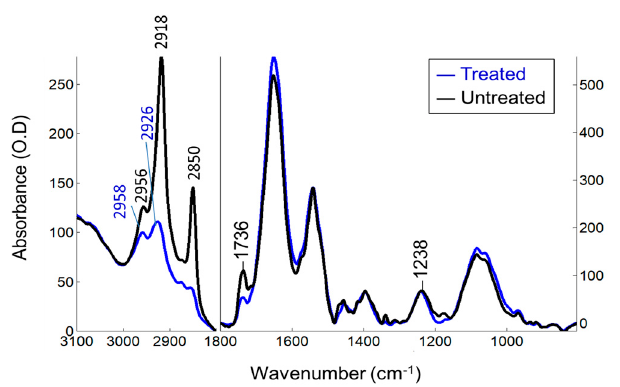
Figure 1. The FTIR mean absorbance spectra for CPT - treated and untreated Jurkat cells. The mean spectra were calculated by averaging at least 12 spectra recorded for repeated experiments of each cell condition. The spectra were baseline corrected and normalized to the same area underneath 1585– 1482 cm − 1 . Thus, the absorbance scale presents re-scaled absorbance values. The peak positions are color-coded (treated: blue; untreated: